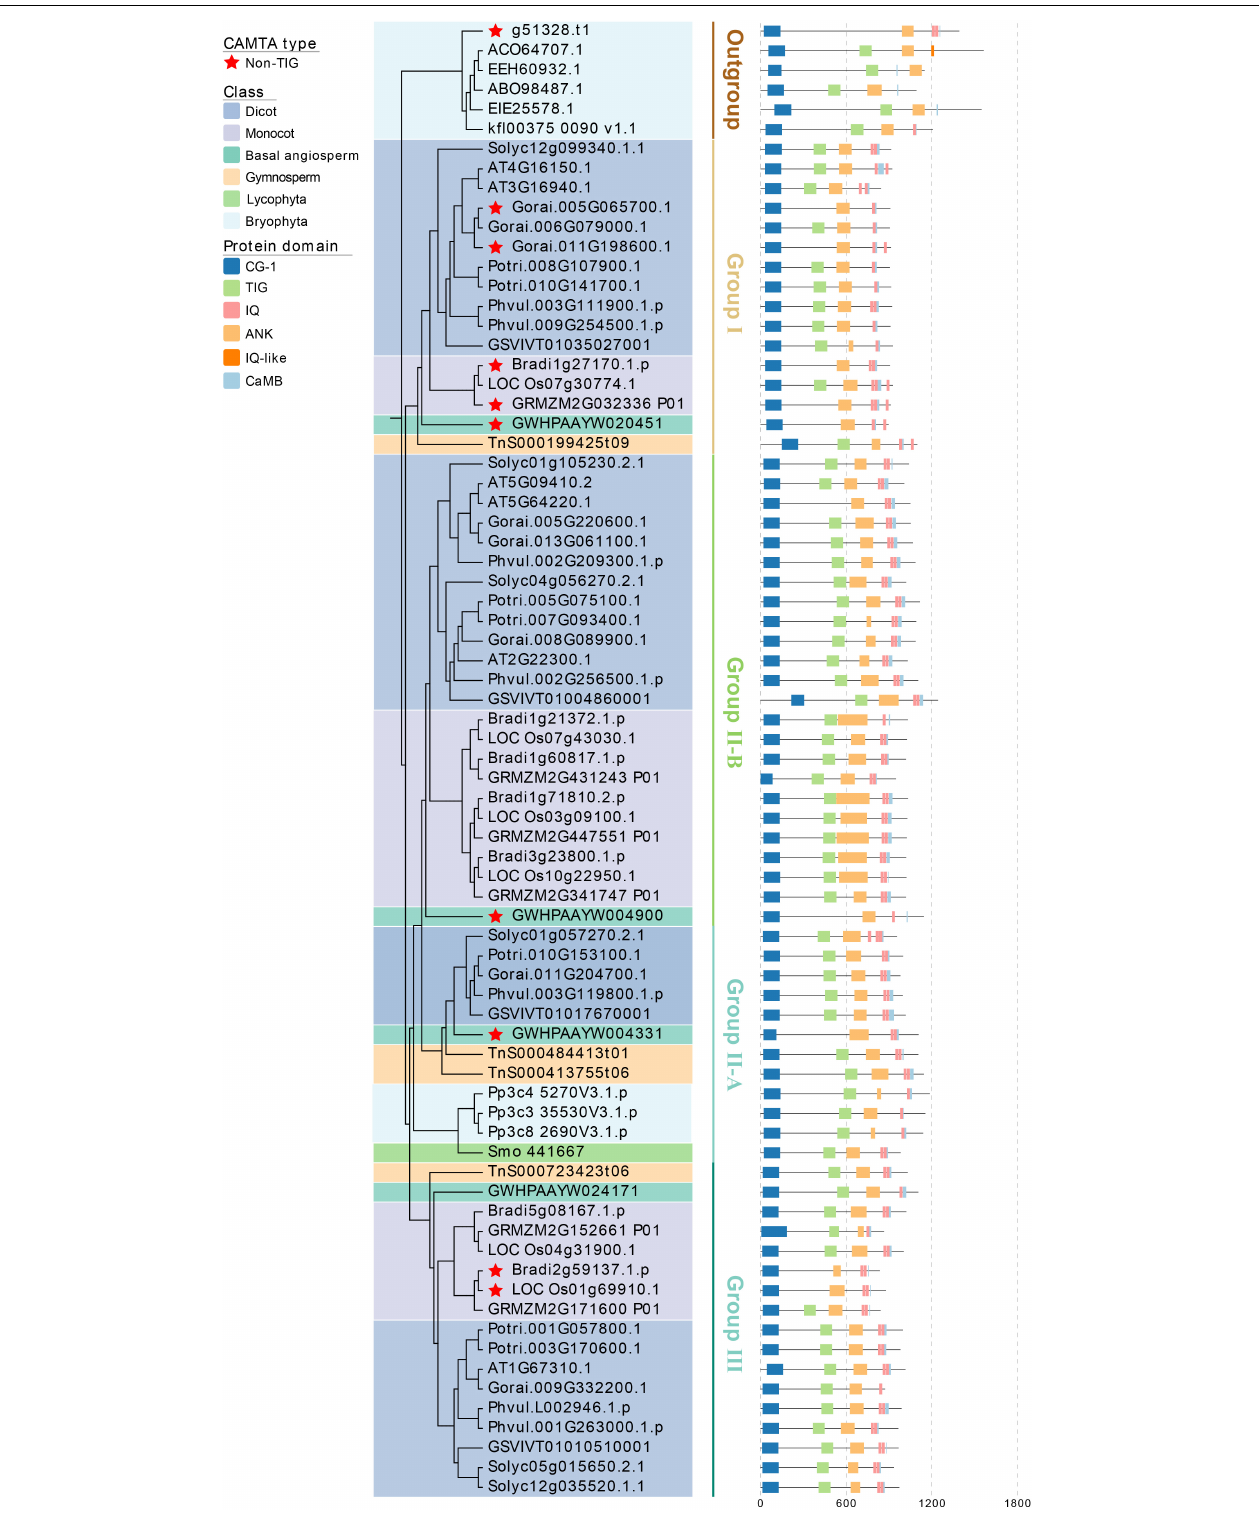
Frontiers in Plant Science |